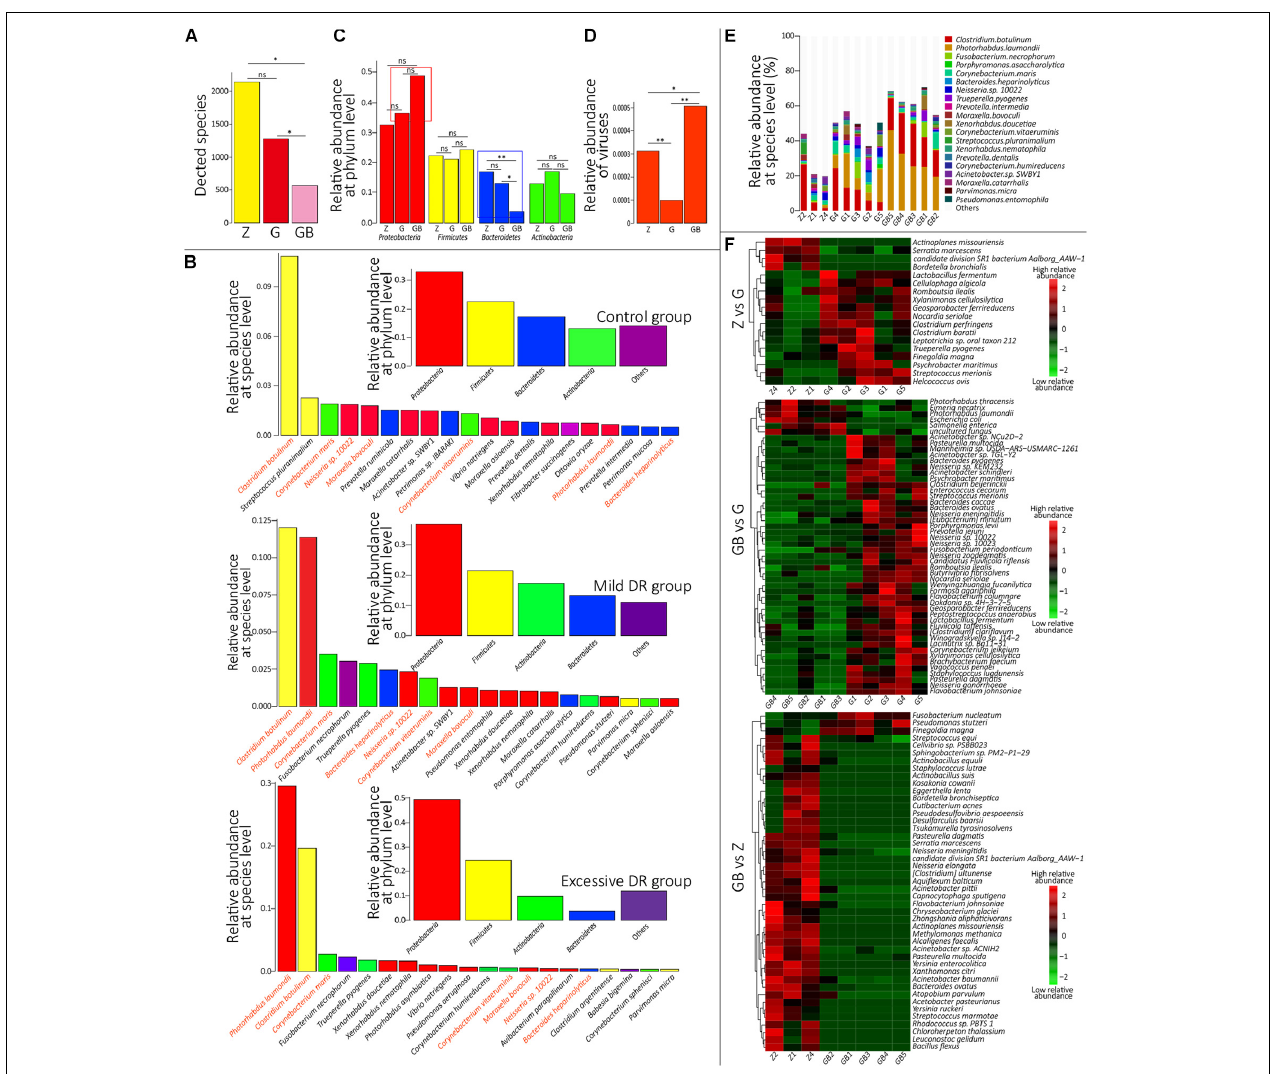
FIGURE 3 | Species annotation analysis. (A) The average detected species number of each group. Z for the control group, G for the mild DR group, GB for the excessive DR group. ns: non-significant, p > 0.05; *0 . 01 < p < 0 . 05. (B) Inner: Top four dominant phyla with the highest average relative abundance in each group. Outer: The top 20 dominant species with the highest average relative abundance in each group. Species with the same color belong to the phyla with the corresponding color. Species name marked by orange means “core species.” (C) The difference of average relative abundance of each of four dominant phyla in each group. Z for the control group, G for the mild DR group, GB for the excessive DR group. ns: non-significant, *0 . 01 < p < 0 . 05; ** p < 0 . 01. (D) The difference of average relative abundance of the detected virus number in each group. Z for the control group, G for the mild DR group, GB for the excessive DR group. ns: non-significant, *0 . 01 < p < 0 . 05; ** p < 0 . 01. (E) The top 20 dominant species with the highest average relative abundance in each sample and their percentages, Z for the control group, G for the mild DR group, GB for the excessive DR group. (F) Heat map shows the top 50 species with the highest significance among groups. Z for the control group, G for the mild DR group, GB for the excessive DR group. Red indicates that the species has higher relative abundance, whereas green indicates that the species has lower relative abundance. The value is the result of the Z scoring of species relative abundance; the bigger value of color, the higher relative